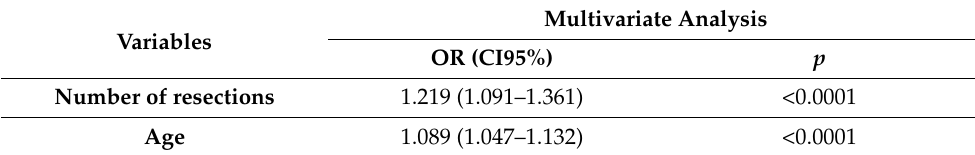
Table 7. Multivariate analysis for grade V complications (total 952 cases).